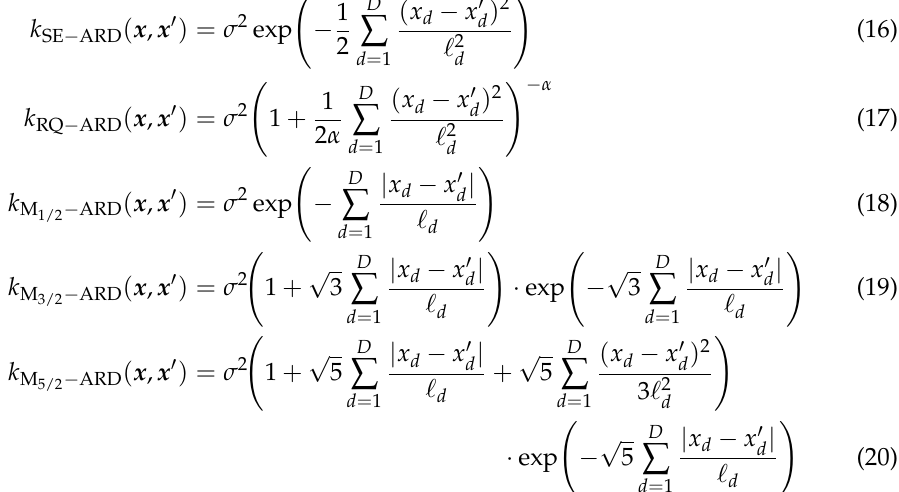
Figure 5. Observation-based one-step-ahead GPR model with kernel k SE horizon model is obtained by iteration. GHI ( t observations, and ∆ t = 10 min is the time